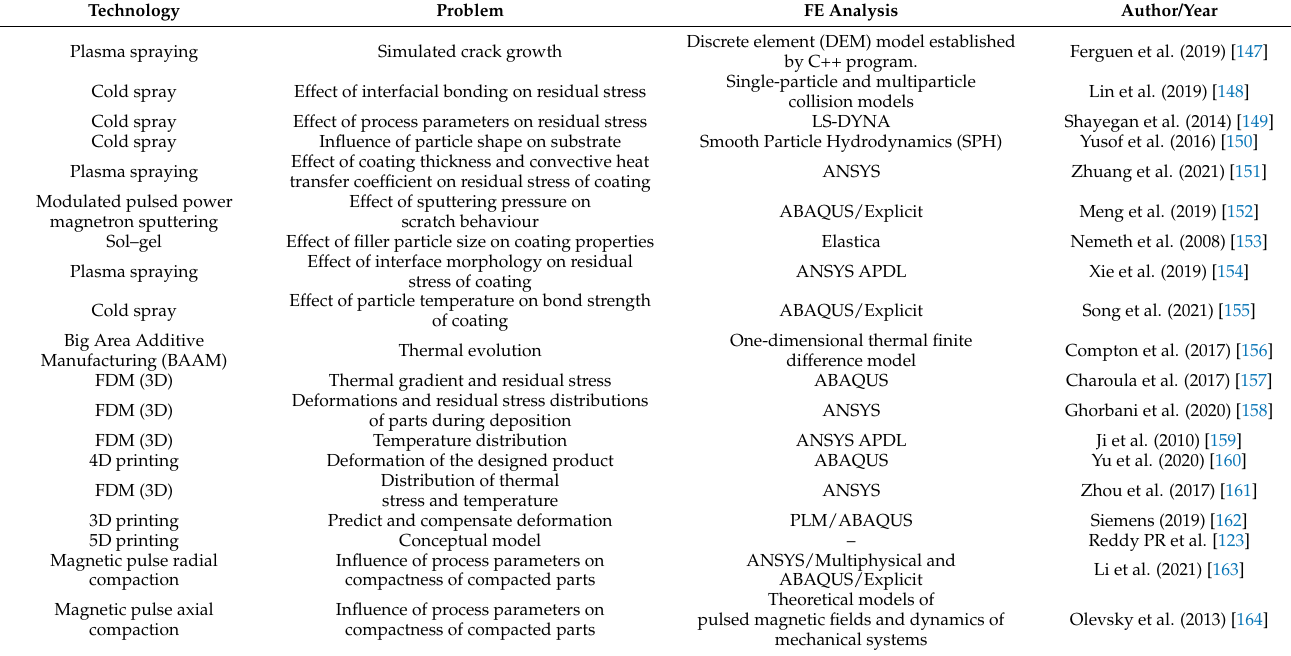
Table 6. The different polymer composite manufacturing